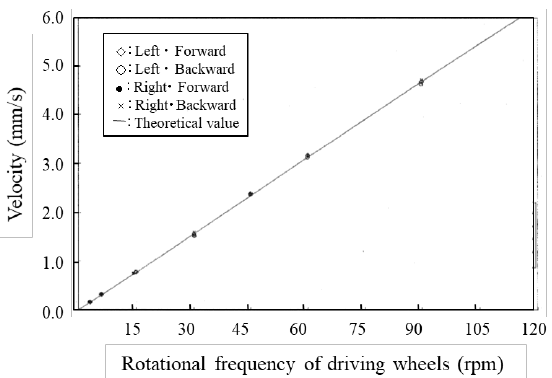
Figure 17. Relationship between the speed of left and right target marks and rotational frequency of driving wheel in forward and backward movement. The marks show the measurement results and the solid line shows the theoretical line.